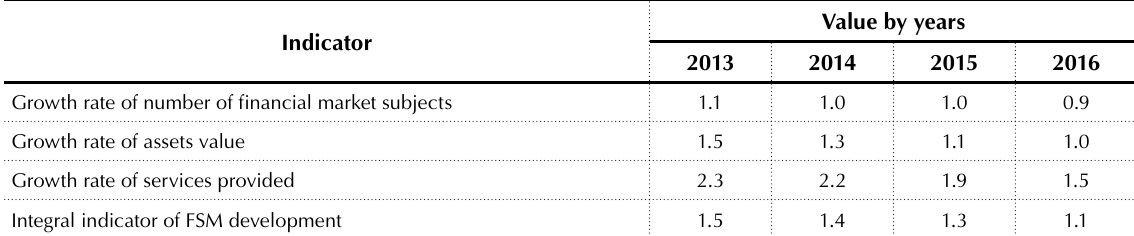
Table 5. Assessment of the Ukrainian financial market development in 2013–2016